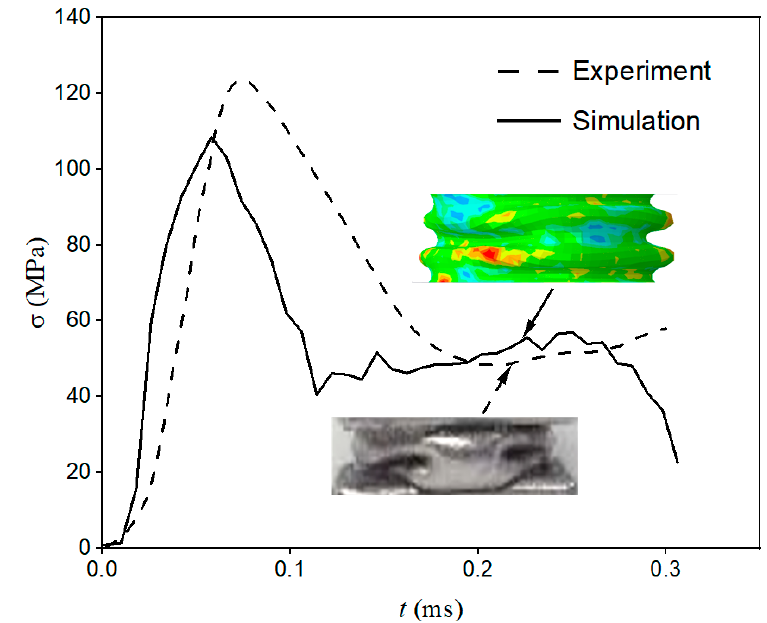
Figure 4. Stress–time curve of empty tube experiment and simulation.